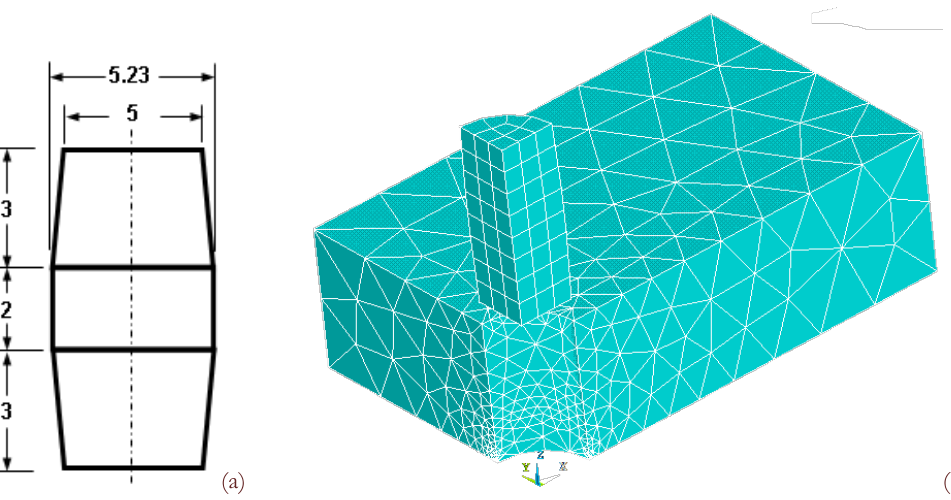
Figure 3: Cold expansion process a) Detail of tapered pin used for cold expansion, b) Mesh using 3D finite element model.